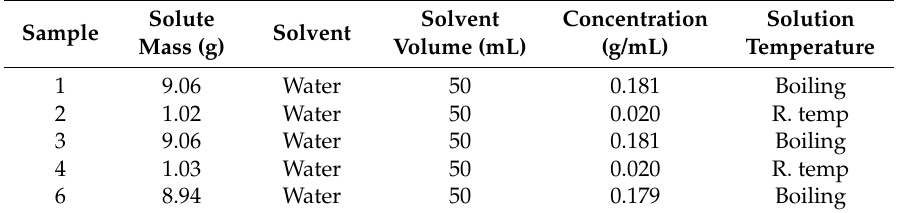
Table 2. Impregnation (2) conditions of the samples.